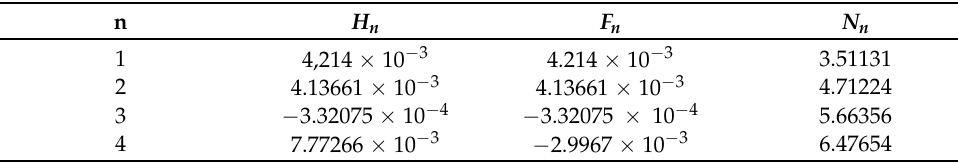
Table 1. First four values of H n , F n and N n ; see Equations (37)–(42).